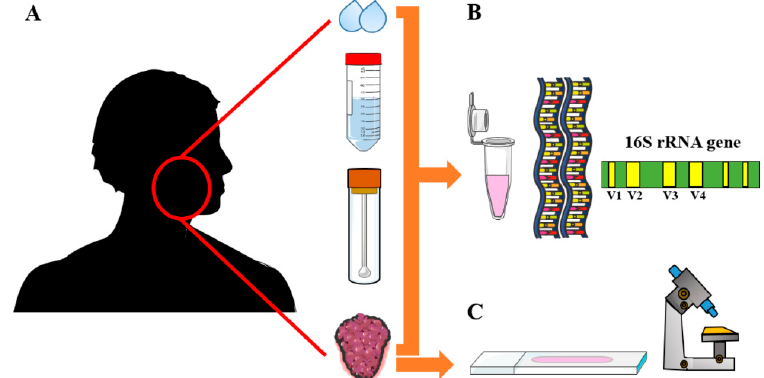
Figure 2. The different methods used for collecting and characterizing oral microbiota from patients with head and neck squamous cell carcinoma. ( A ) Oral microbiota samples are obtained by means of saliva expectoration; mouth wash samples; oral swab samples; or tissue biopsy. ( B ) Oral microbiota were characterized by DNA-DNA hybridization; primers targeting the 16S ribosomal RNA gene. ( C ) Immunohistochemistry of tumor sections was also used to identify oral microbiota.